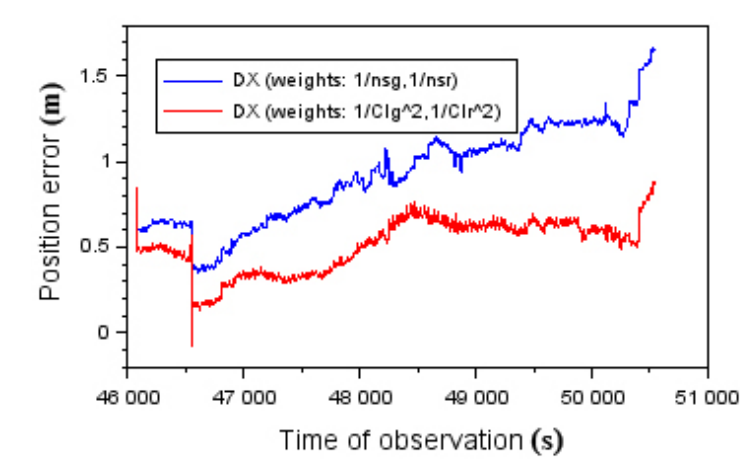
Figure 16. Position errors along the X -axis.